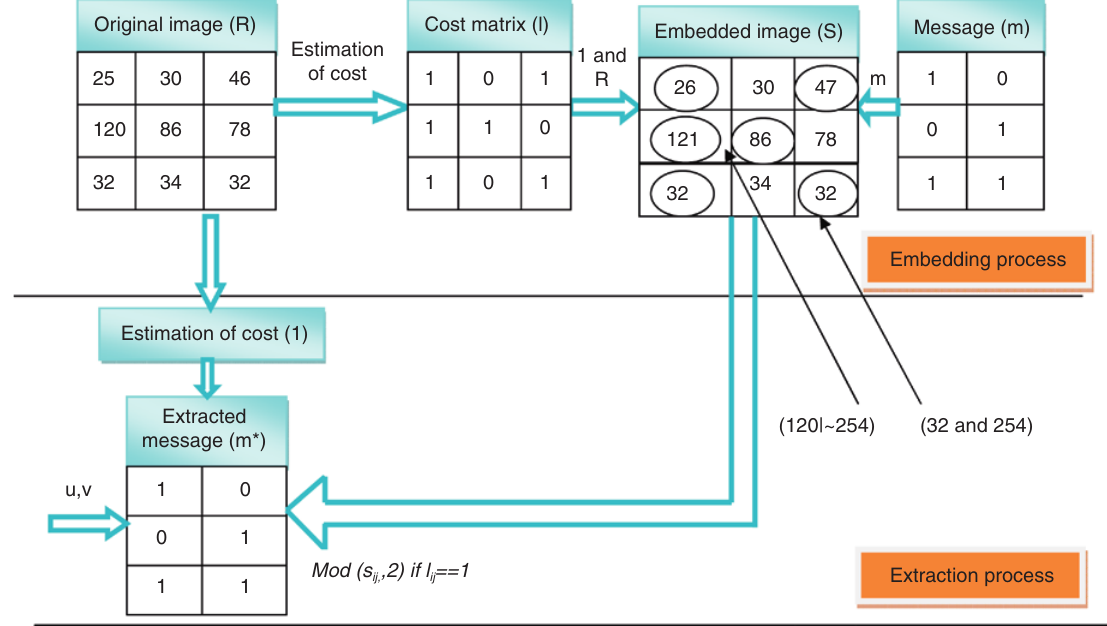
Figure 2: Example of Embedding and Extraction